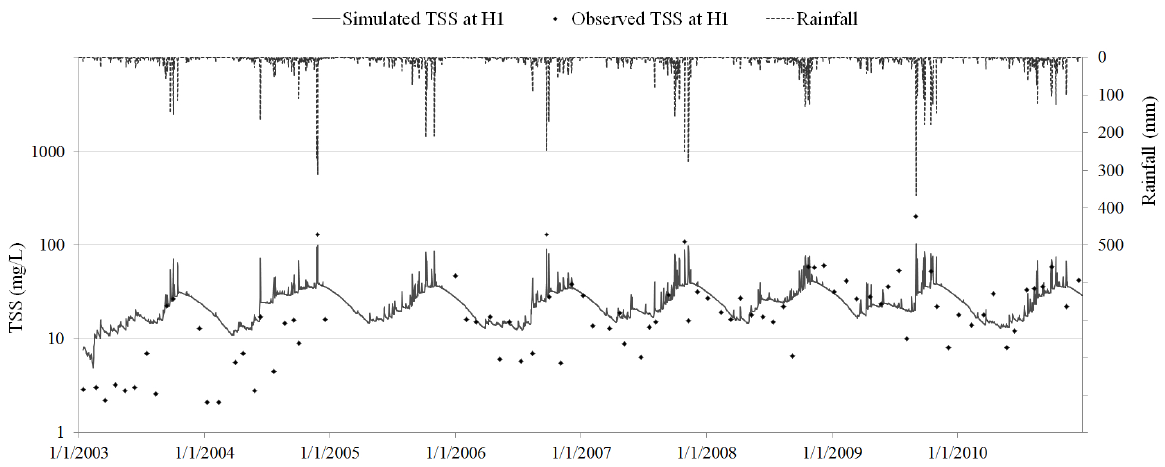
Figure 6. TSS calibration at